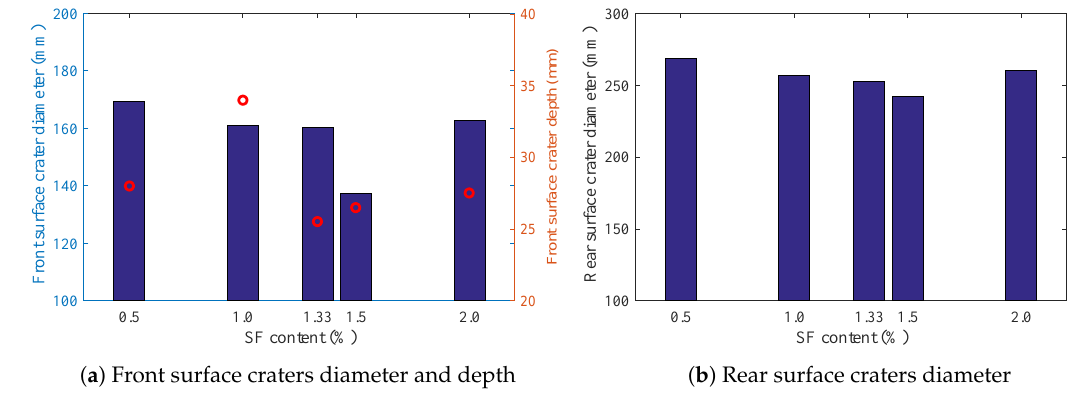
Figure 9. Post-blast front and rear surface craters of PP-Steel HFRC panels.